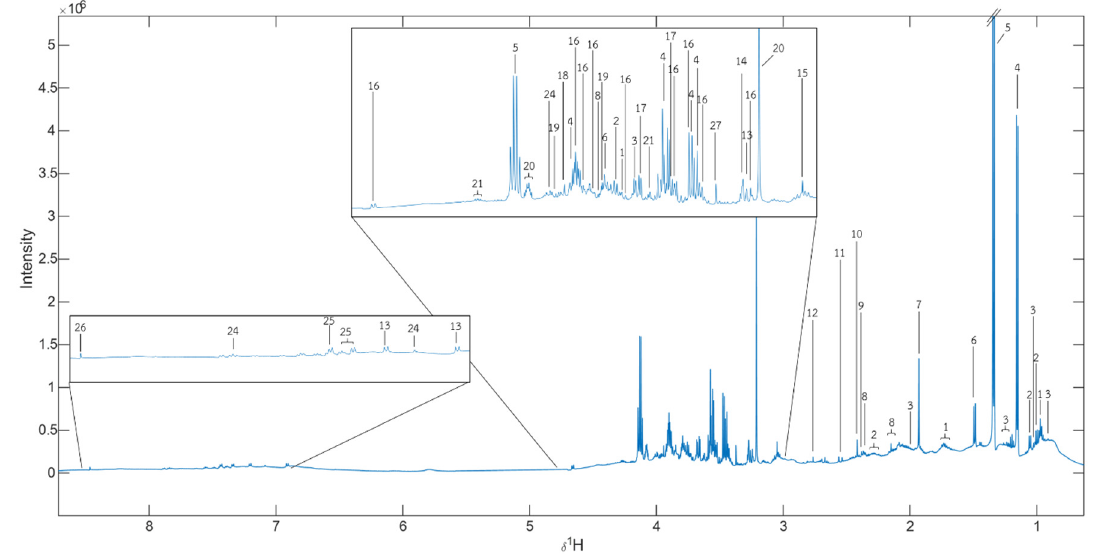
Figure 5. δ H median NMR spectra of all samples. 1 = Leu, 2 = Val, 3= Ile, 4 = Propylene glycol, 5 = Lactate, 6 = Ala, 7 = Unknown 1, 8 = Met, 9 = Pyruvate, 10 = Succinate, 11 = Unknown 2, 12 = Butanedinitrile, 13 = Tyramine, 14 = Betaine, 15 = Creatinine, 16 = α -D-glucose, 17 = Glycerol, 18 = Glycolate, 19 = Ser, 20 = Choline, 21 = Thr, 22 = Fumarate, 23 = Tyr, 24 = His, 25 = Protocatechuic acid, 26 = Formate, 27 = Unknown 3.